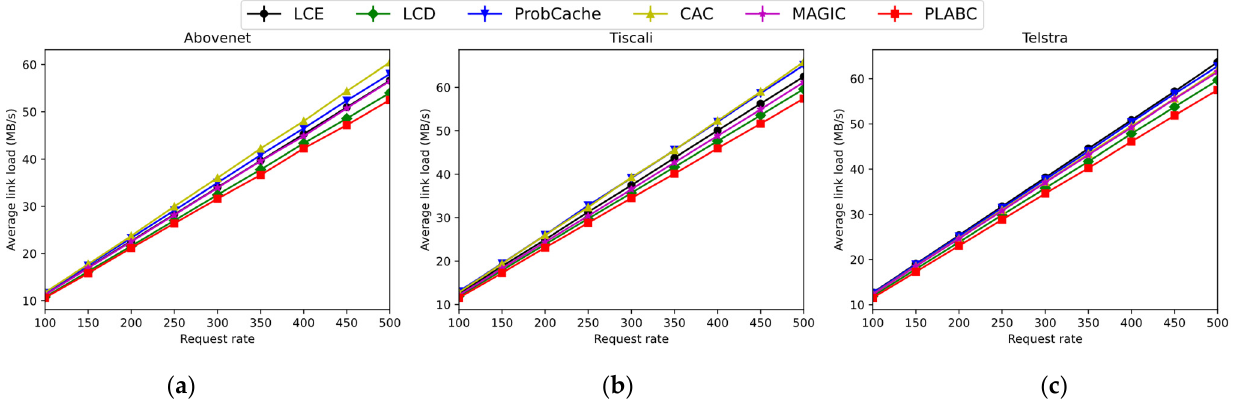
Figure 15. Average link load results of different caching strategies when the total request rate varies under topology: ( a ) Abovenet; ( b ) Tiscali; ( c ) Telstra.